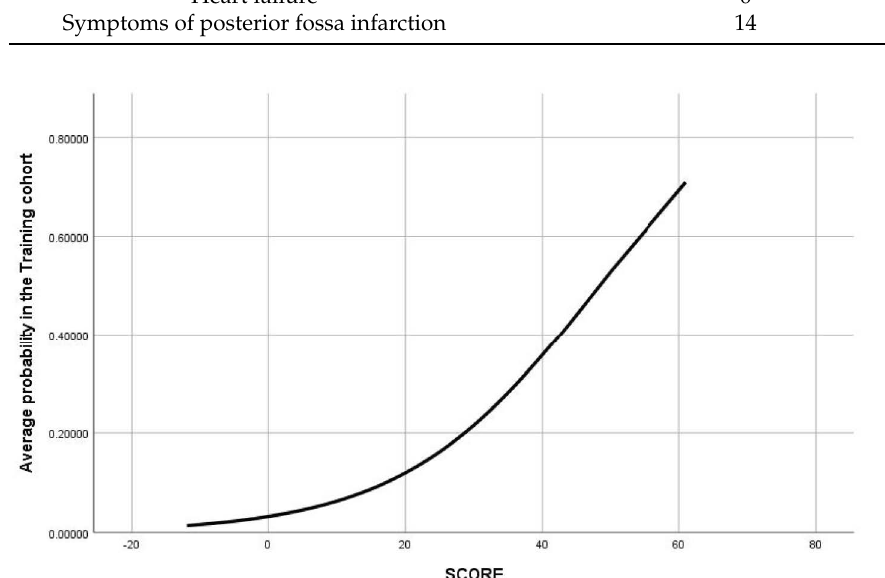
Figure 5. Relation between the risk score and the risk of